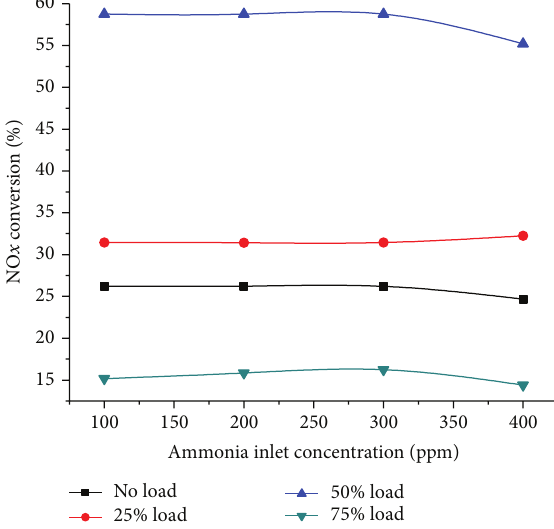
Figure 10: NO 𝑥 conversion versus ammonia inlet